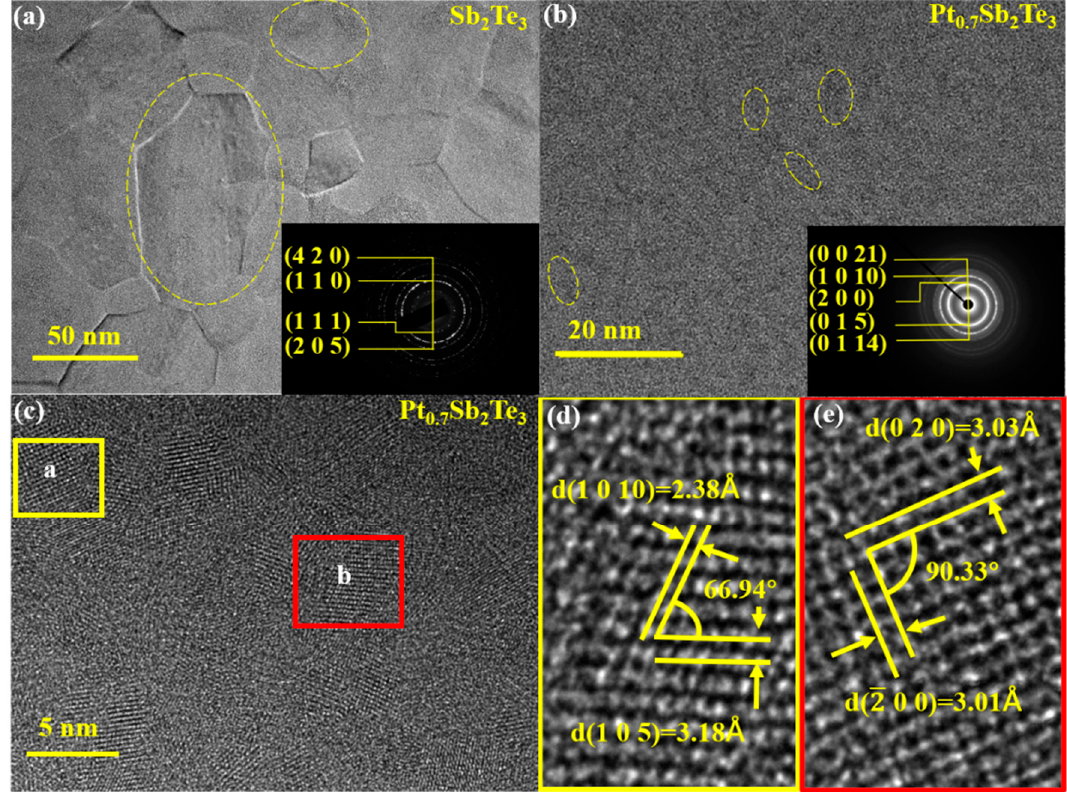
Figure 3. ( a ) TEM image of Sb 2 Te 3 film after annealed at 260 °C. ( b ) TEM image of PST film after annealed at 260 °C. ( c – e ) HRTEM images of PST film after annealed at 260 °C.